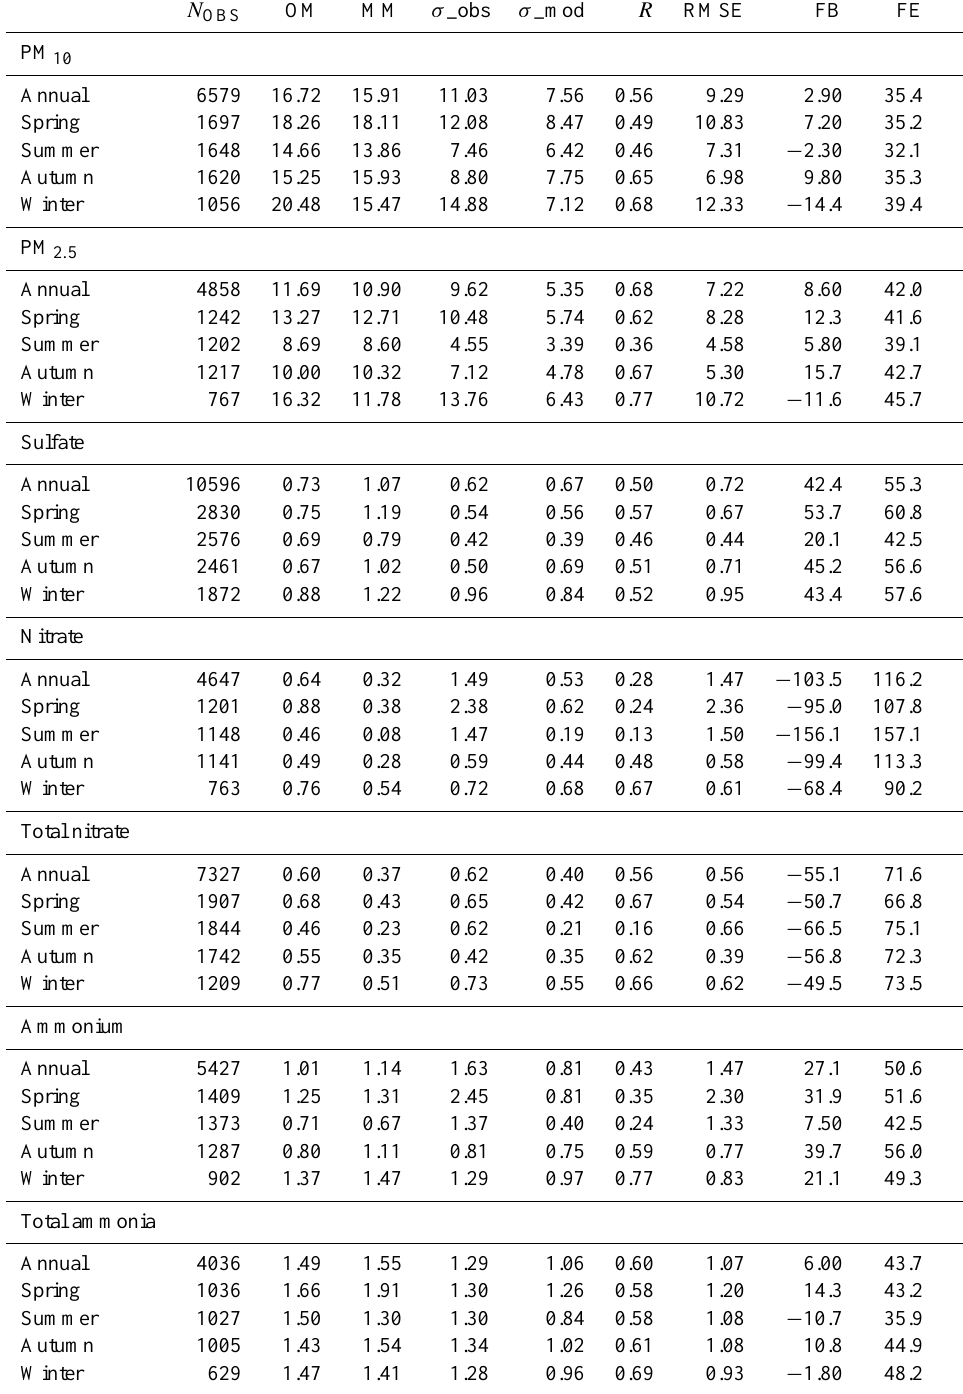
Table 6. Annual and seasonal scores calculated using the RB EMEP stations. The indicators and the associated units are identical to those in Table